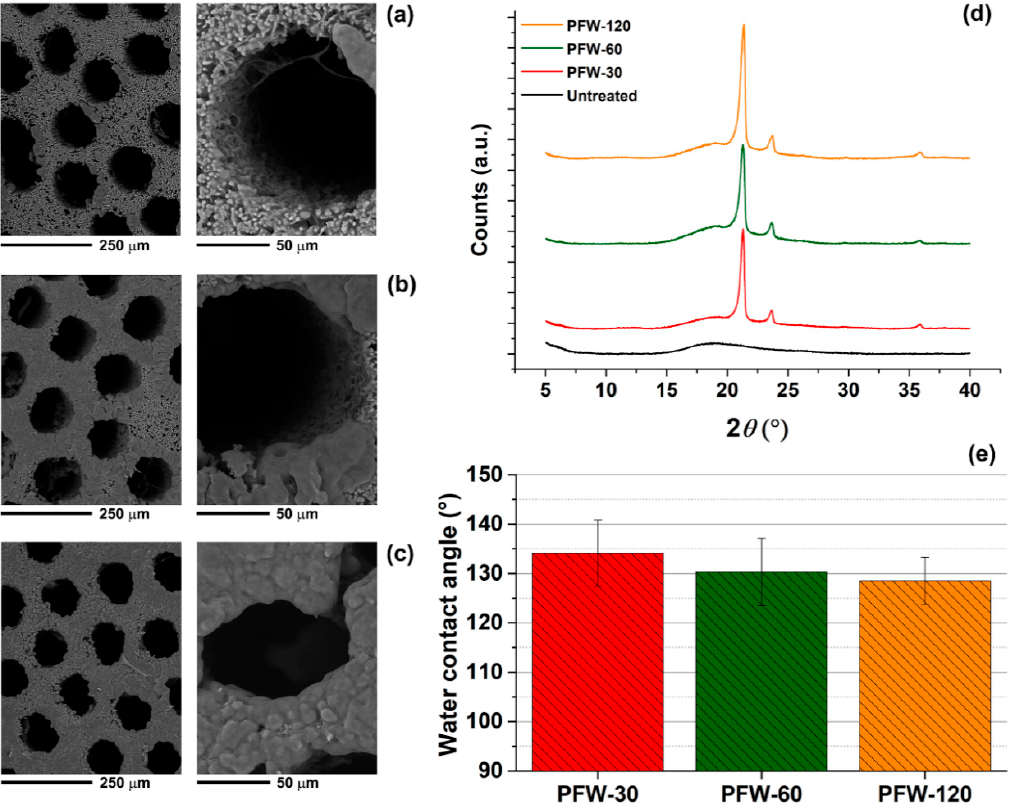
Figure 2. ( a – c ) SEM images, at two different magnifications, of the surface porosity of G. applanatum samples treated with paraffin wax for 30, 60 and 120 s, respectively. ( d ) XRD patterns of untreated and paraffin wax (PFW)-treated samples. ( e ) Water contact angle analysis of PFW-30, PFW-60 and PFW-120 samples.